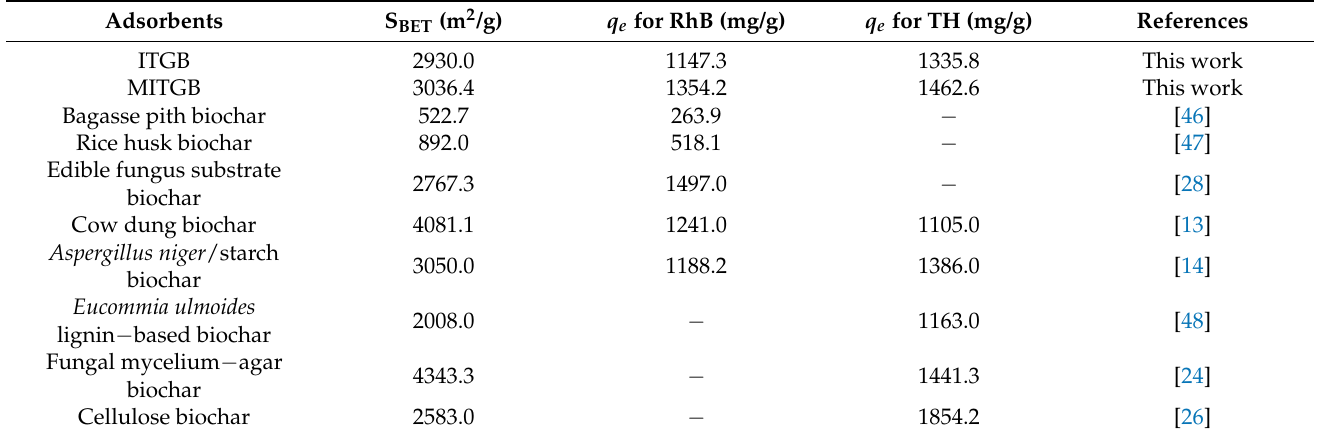
Table 5. Comparison of ITGB and MITGB to RhB and TH with other biochars.